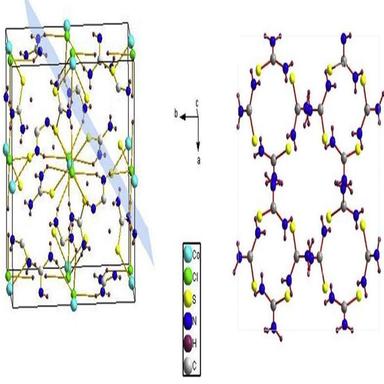
The organic matrix of tetrakis(thiourea)cobalt chloride crystal.